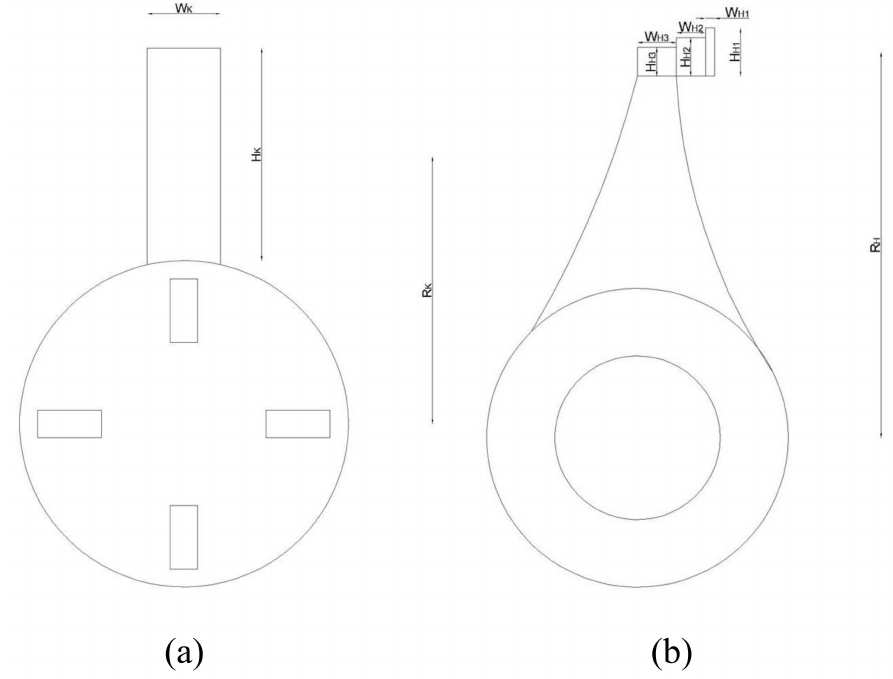
Figure 4. Schematic representation of a single tool of a hammer crusher ( a ) and knife crusher ( b